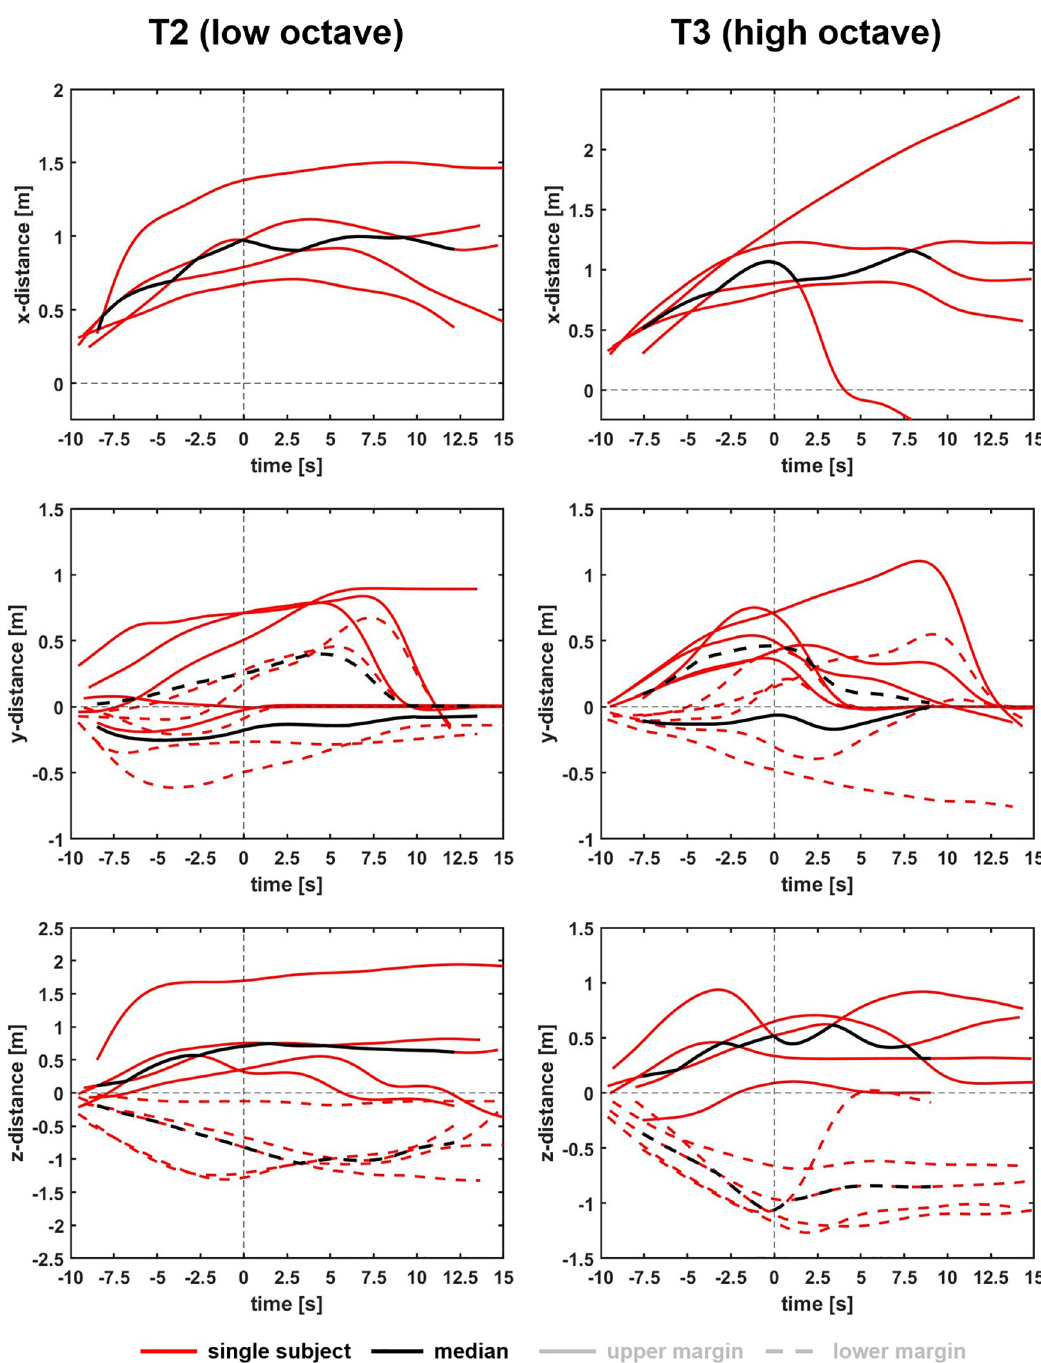
Fig 3. Results of tasks 2 and 3. Aerosol dispersion distances of all subjects (red) and medians (black) over all subjects in task 2 (low octave) and task 3 (high octave) for x- (front), y- (side), and z- (vertical) direction. The distances are measured from the subjects’ mouth. The zero in the time domain is set as the end of the